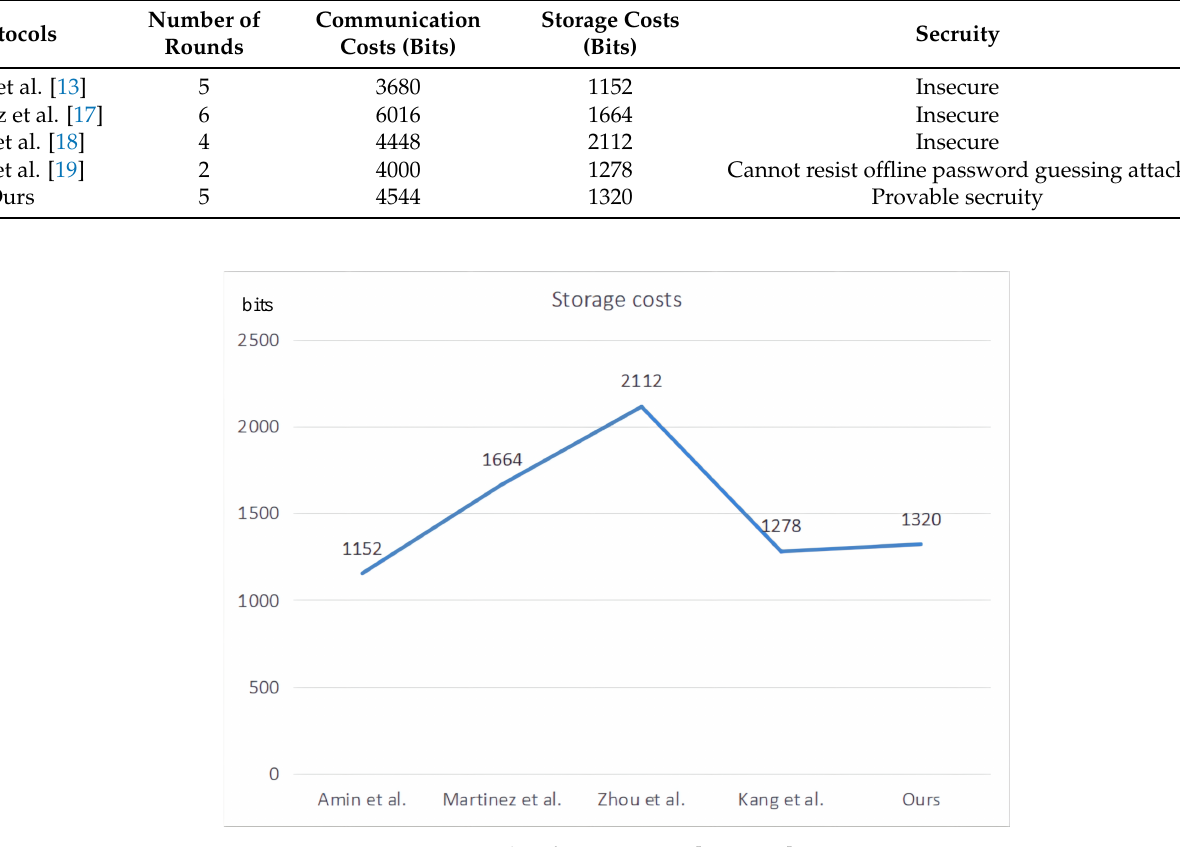
Figure 11. Comparative results of storage costs